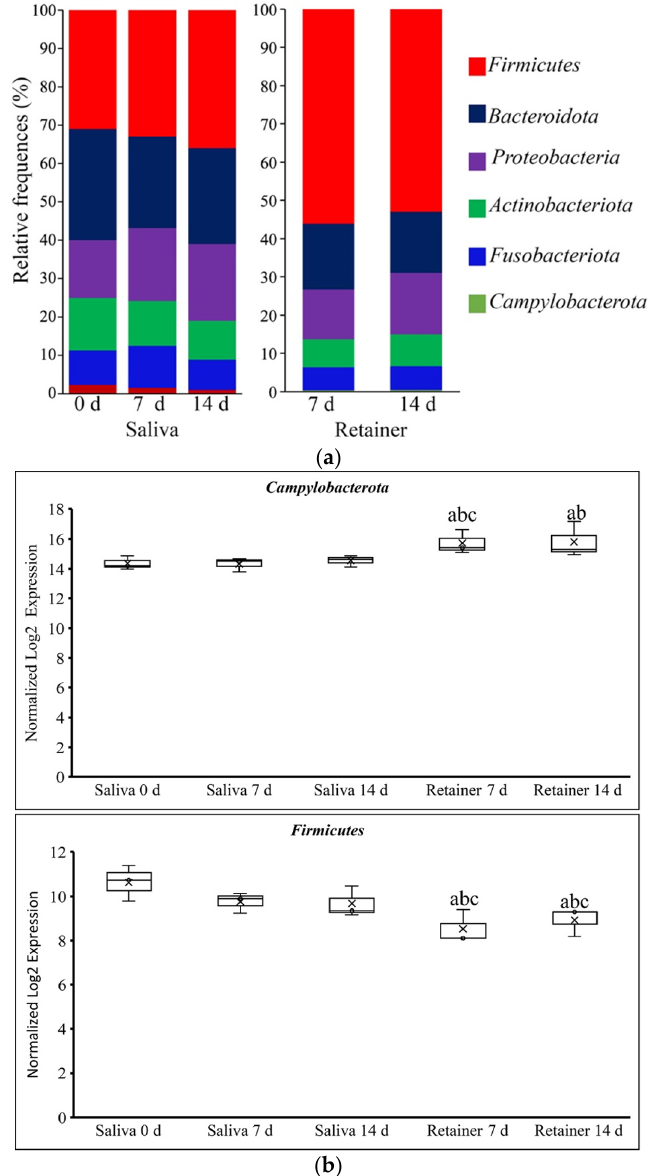
Figure 3. Analyses of the changes in microbial structure at the phylum level. ( a ) The distributions of predominant oral microbial taxa (relative frequency) at the phylum level in the saliva and retainer, with each color representing one phylum. ( b ) Comparison of oral microbiota normalized log2 fold changes at the phylum level in saliva and retainer after 7 and 14 days. a: Compared to salivary bacteria at 0 days. b: Compared to salivary bacteria at 7 days. c: Compared to salivary bacteria at 14